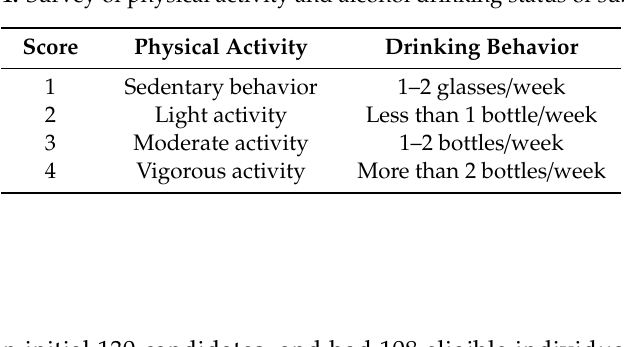
Table 1. Survey of physical activity and alcohol drinking status of subjects.